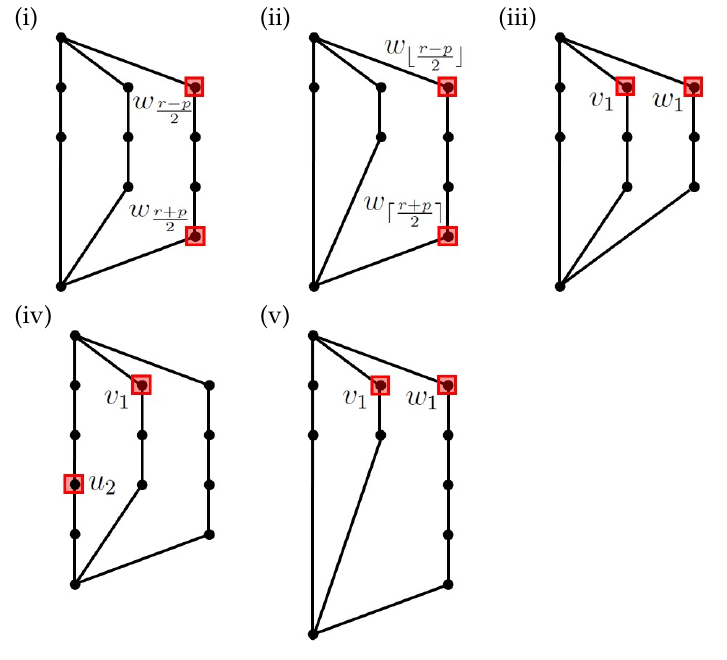
Figure 3. Edge metric generators from Lemma